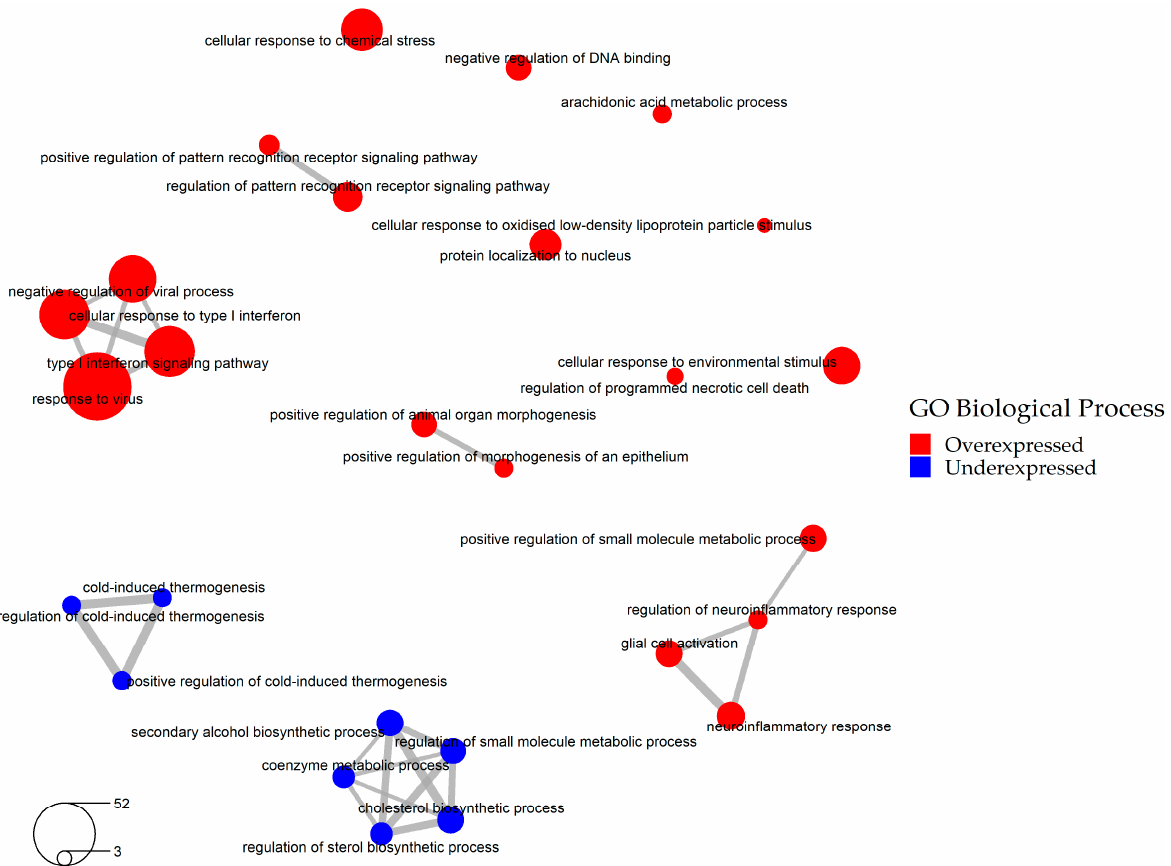
Figure 3. Network of significantly enriched pathways involved in SARS-CoV-2 infection (Gene Ontology Biological Process database, based on 636 consensus DEGs).